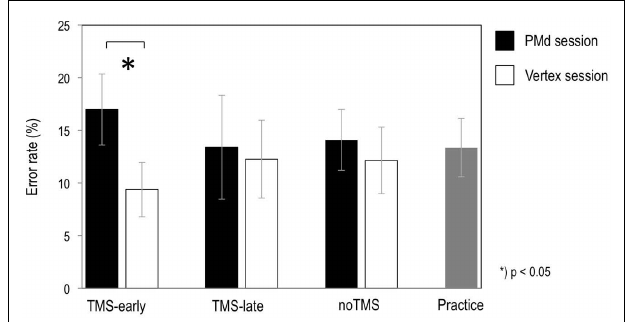
FIGURE 2 | Graphs show the mean error rates forTMS-early and TMS-late in the left PMd and in theVX. Error rates from noTMS trials (i.e., trials withoutTMS that were randomly intermixed betweenTMS trials in each session) and from the practice session were taken as measures of baseline performance. Errors were those cases when a time-coherent action continuation was misjudged as being time-incoherent. Bars represent SE.